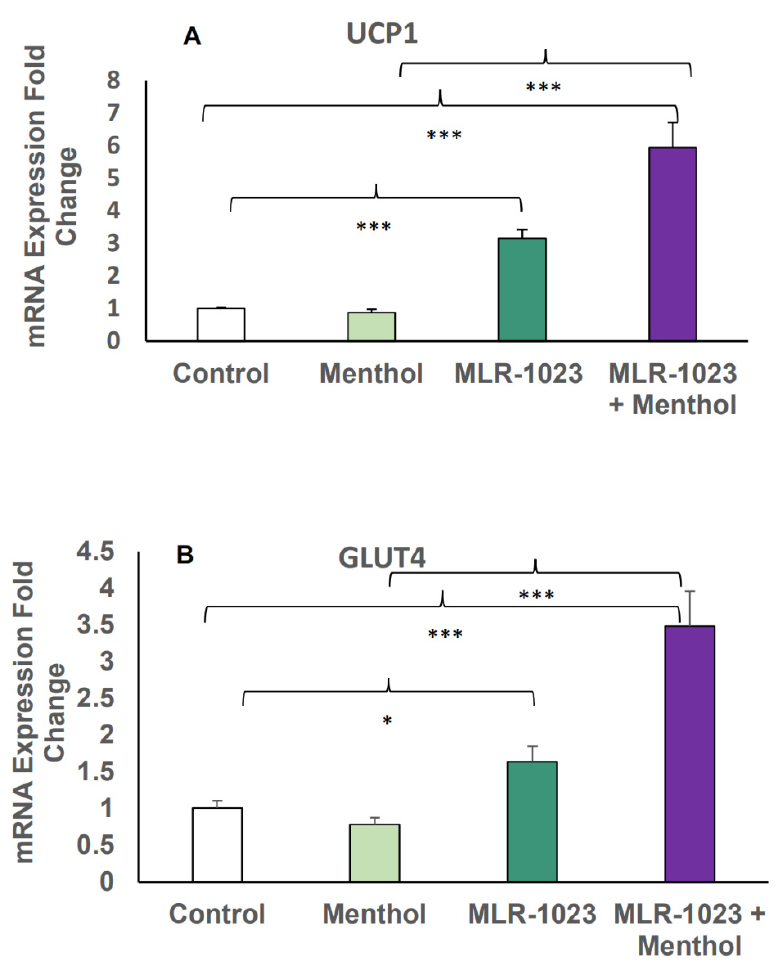
Figure 6. mRNA expression in human adipocytes (HASCs) treated with MLR-1023 and menthol. qRT-PCR assays conducted in duplicates following MLR-1023 (30 µM), menthol (30 µM), and MLR-1023 in addition to menthol (30 µM each) treatment of human adipocytes from three obese donors (four technical replicates each) compared to untreated adipocytes (control): ( A ) uncoupling protein 1 (UCP1) and ( B ) glucose transporter type 4 (GLUT4). The results are presented as mean ± SE. * p < 0.05, *** p < 0.001 compared to the respective control. MLR-1023 and menthol also exhibit synergy, where the combined effect compared to control is greater than the sum of the effects of MLR-1023 or menthol alone, compared to the control. Values are mean ± SE, *** p ≤ 0.001.